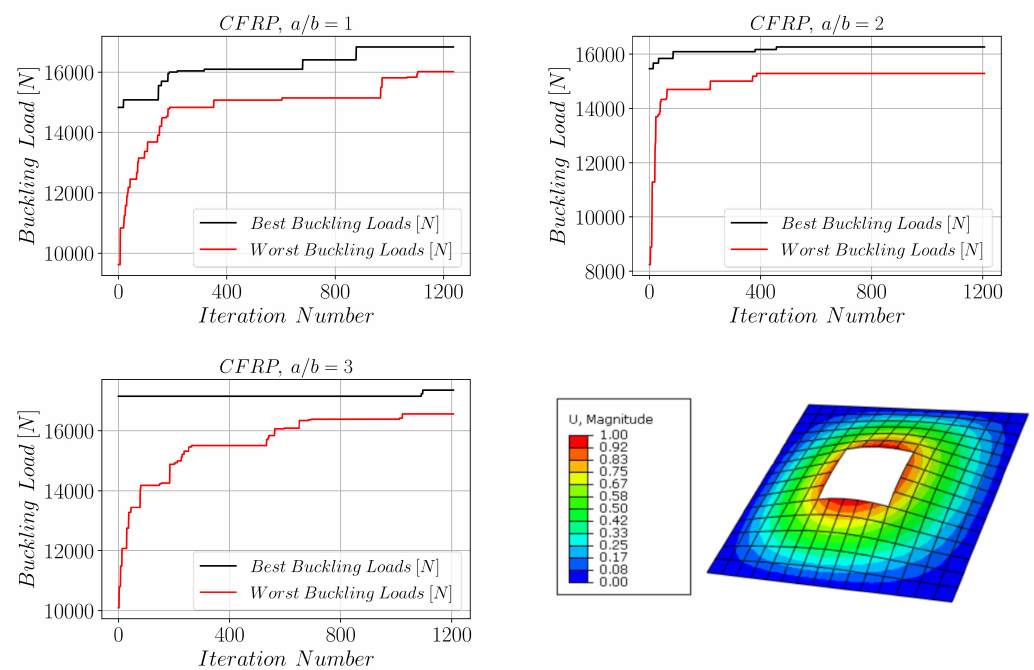
Figure 11. The development of the best and worst-performing stacking sequences in the harmony search optimization for all aspect ratios with rectangular cut-out under uniaxial compression parallel to the longer edge.